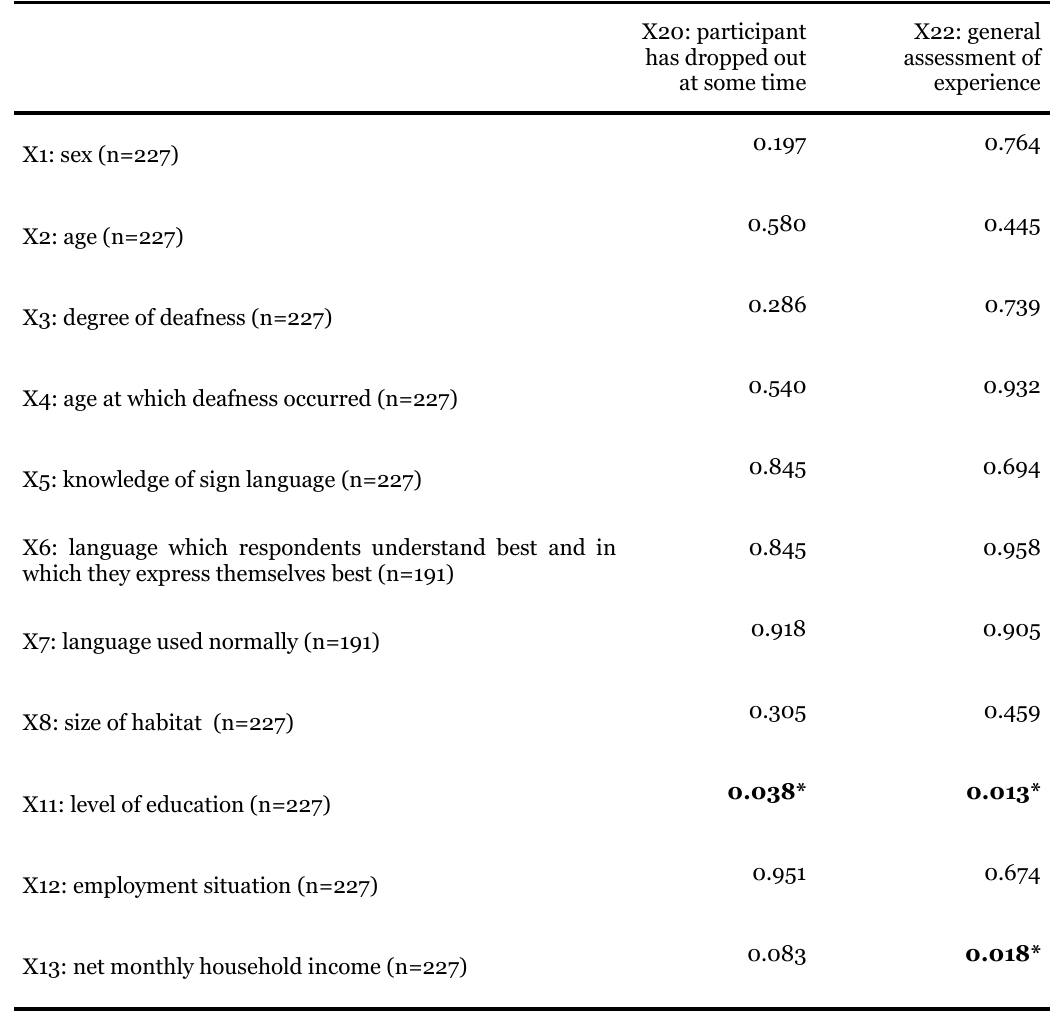
Table 4 P-Values of the Chi-Squared Tests for